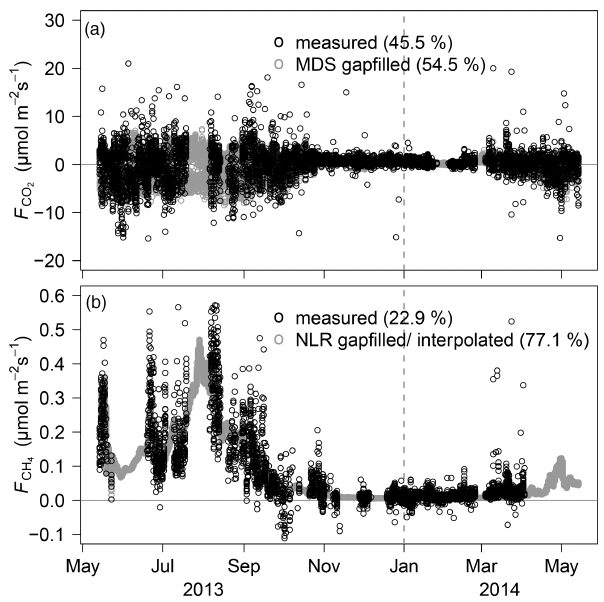
Figure A1. Data coverage of (a) CO 2 and (b) CH 4 fluxes within the study period. Gap-filling results of the MDS CO NLR CH approaches are added as grey circles. The percent- 4 nofoot ages in brackets indicate the time series coverages of measurements and gap-filling